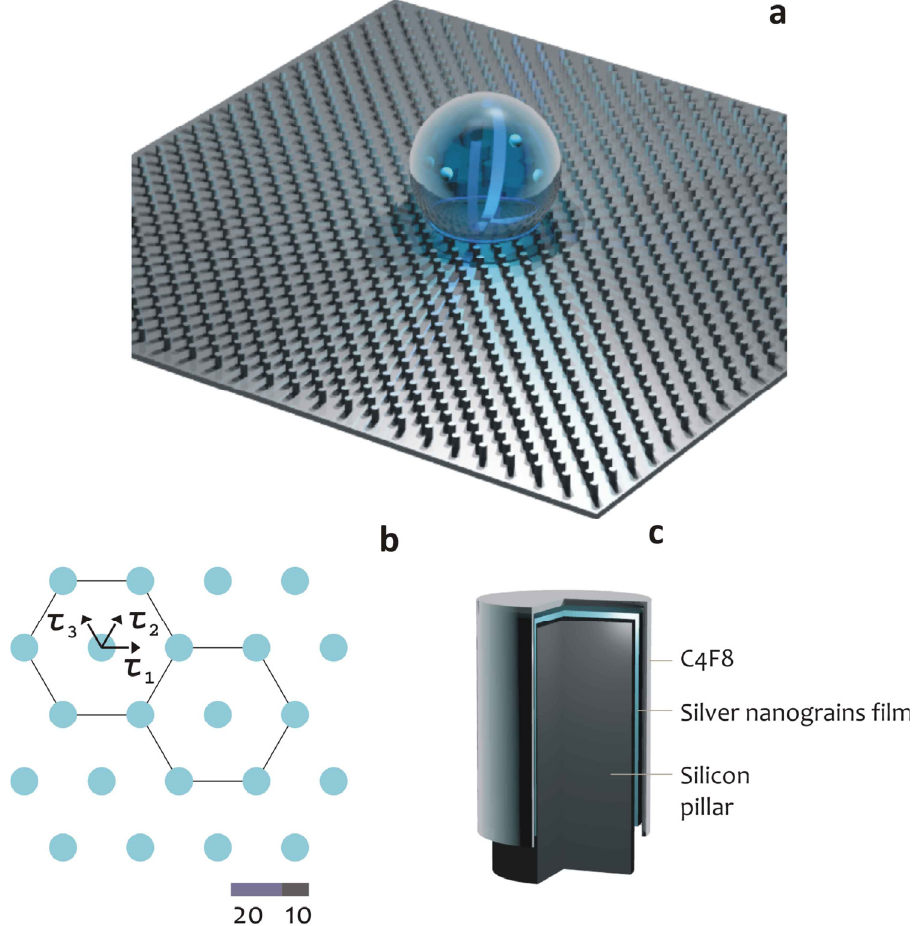
Figure 1. Cartoon representation of a super-hydrophobic surface ( a ); here, the pattern at the microscale recovers a hexagonal periodic lattice ( b ); each silicon micropillar is covered by features at the nanoscale that can be, for instance, an array of silver nanograins; the entire device is covered by a Teflon thin film, which assures hydrophobicity ( c